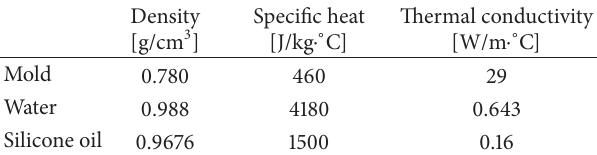
Table 1: Thermal property for mold, water, and silicone oil.